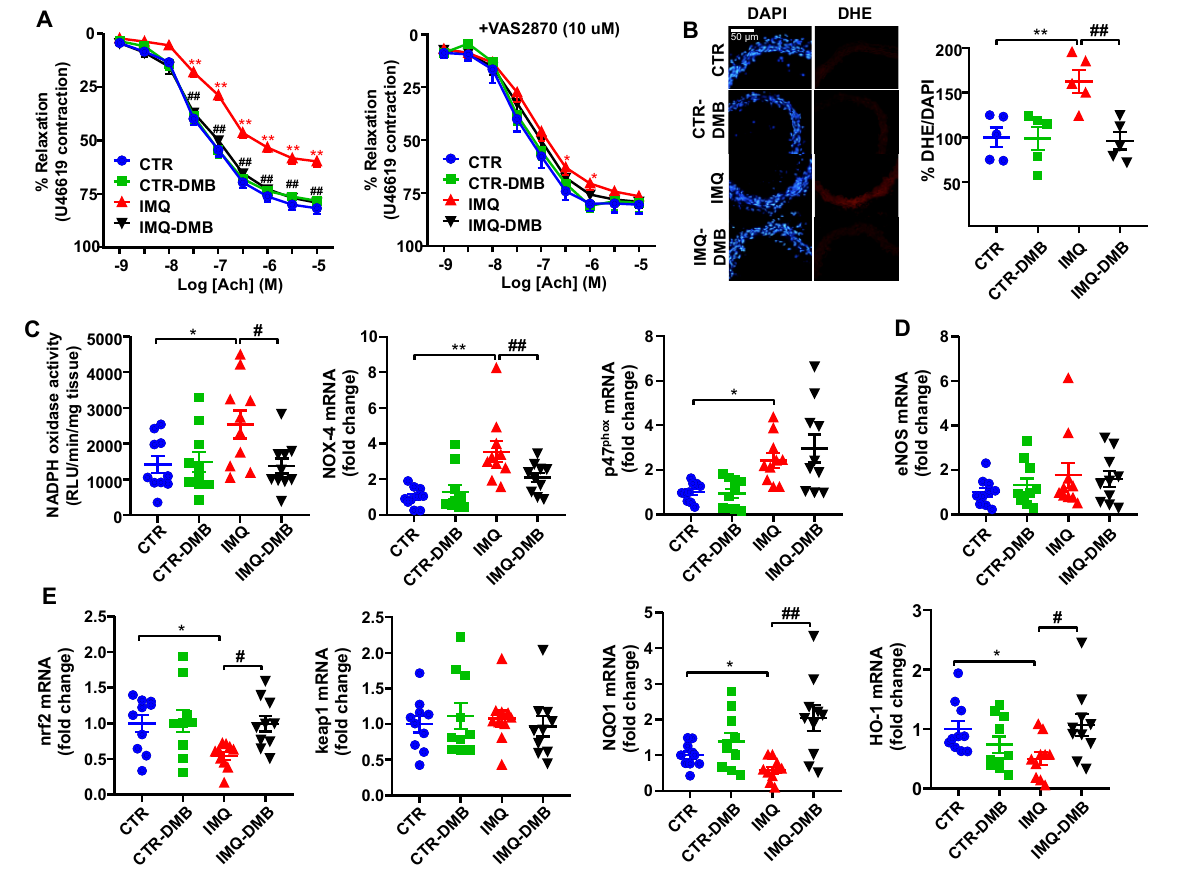
Figure 5. Effects of 3,3-dimethyl-1-butanol (DMB) treatment on SLE-linked endothelial dysfunction, NADPH oxidase activity, and nrf2 pathway in imiquimod (IMQ) mice. ( A ) Acetylcholine (Ach)- induced relaxation responses in aortas pre-contracted by U46619 (10 nM), with or without the specific pan-NOX inhibitor VAS2870 (10 μM). ( B ) ROS content measured by the ratio between red DHE and blue DAPI fluorescence. ( C ) Aortic NADPH oxidase activity determined using a lucigenin-enhanced chemiluminescence and aortic mRNA levels of NADPH oxidase subunits NOX-4 and p47 phox , ( D ) eNOS, and ( E ) nrf2 pathway, measured by RT-PCR. Groups: control (CTR), CTR-group treated with DMB (CTR-DMB), IMQ, and IMQ-group treated with DMB (IMQ-DMB). The data are